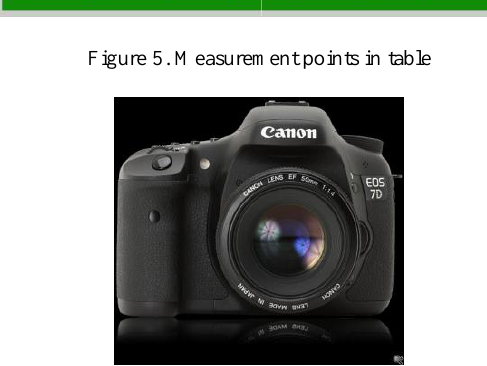
Figure 2. Ball dropping mechanism